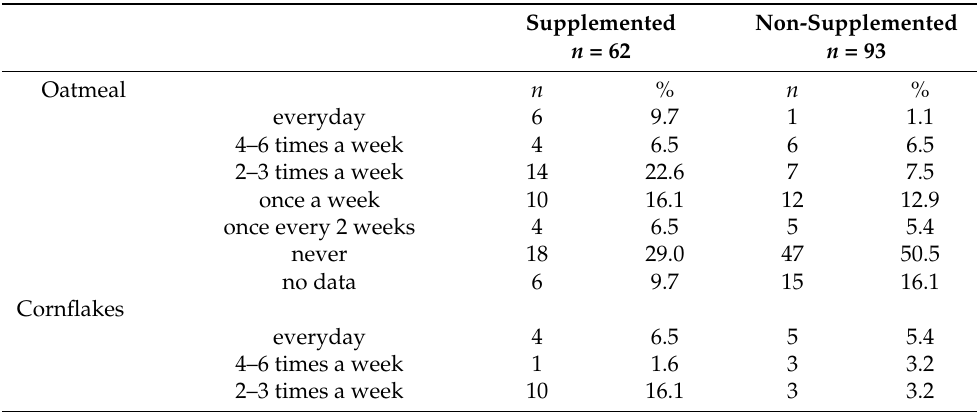
Table A6. Flakes, cereals, and seeds consumption among investigated